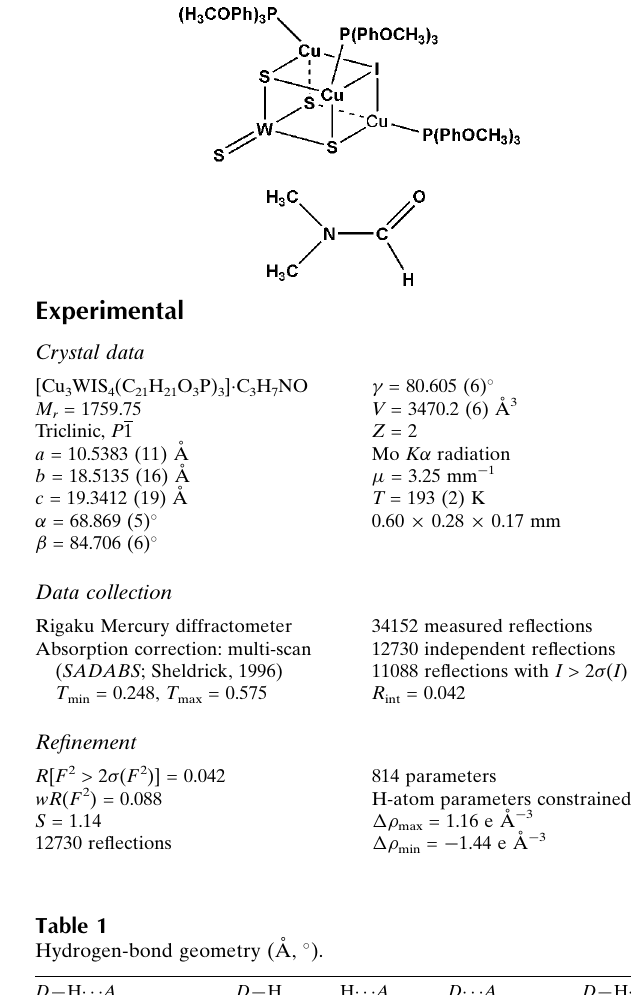
Hydrogen-bond geometry (A˚ , (cid:2)